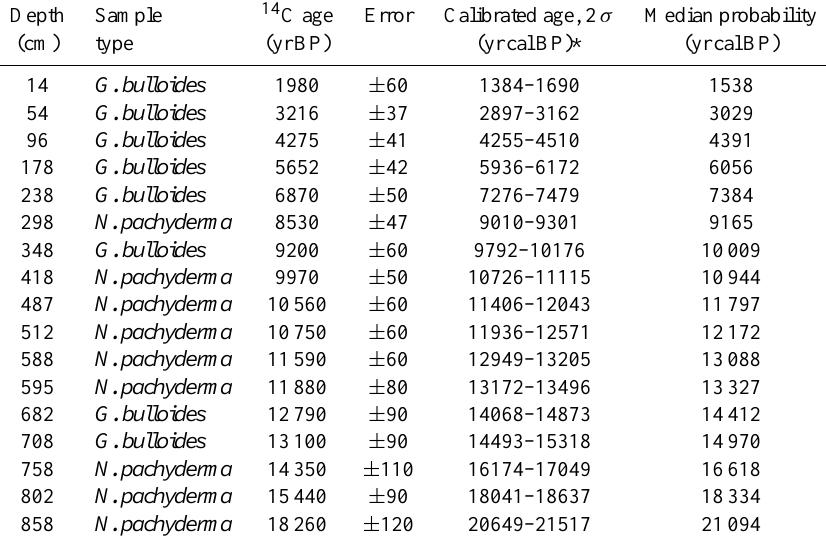
Table 1. AMS radiocarbon dates from core MD95-2043 (Cacho et al., 1999) used in the deglaciation age model.